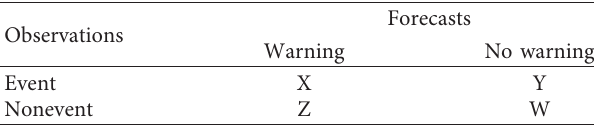
Table 1: Two-by-two contingency table of the warning results for an event.